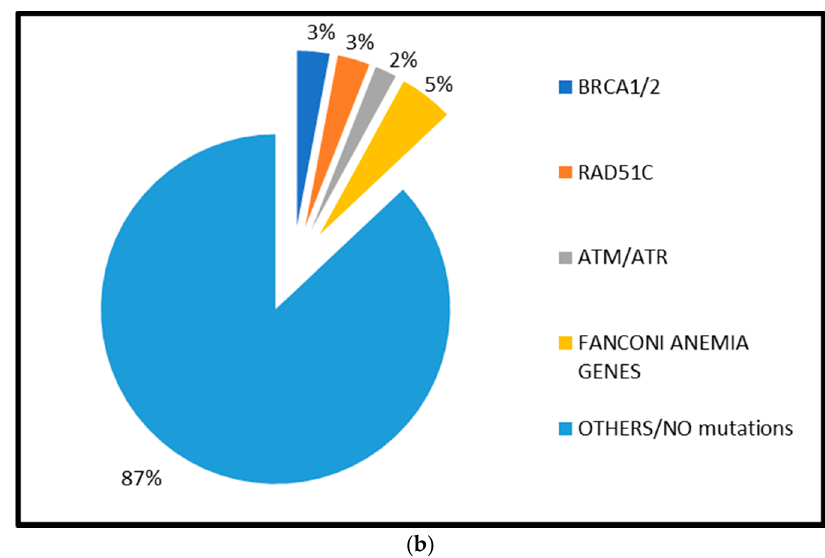
Figure 1. Distribution of homologous recombination deficiency (HRD) genes’ mutations in high grade serous ovarian cancers (HGSOCs): ( a ) germline mutations; ( b ) somatic mutations (data from The Cancer Genome Atlas [1]).